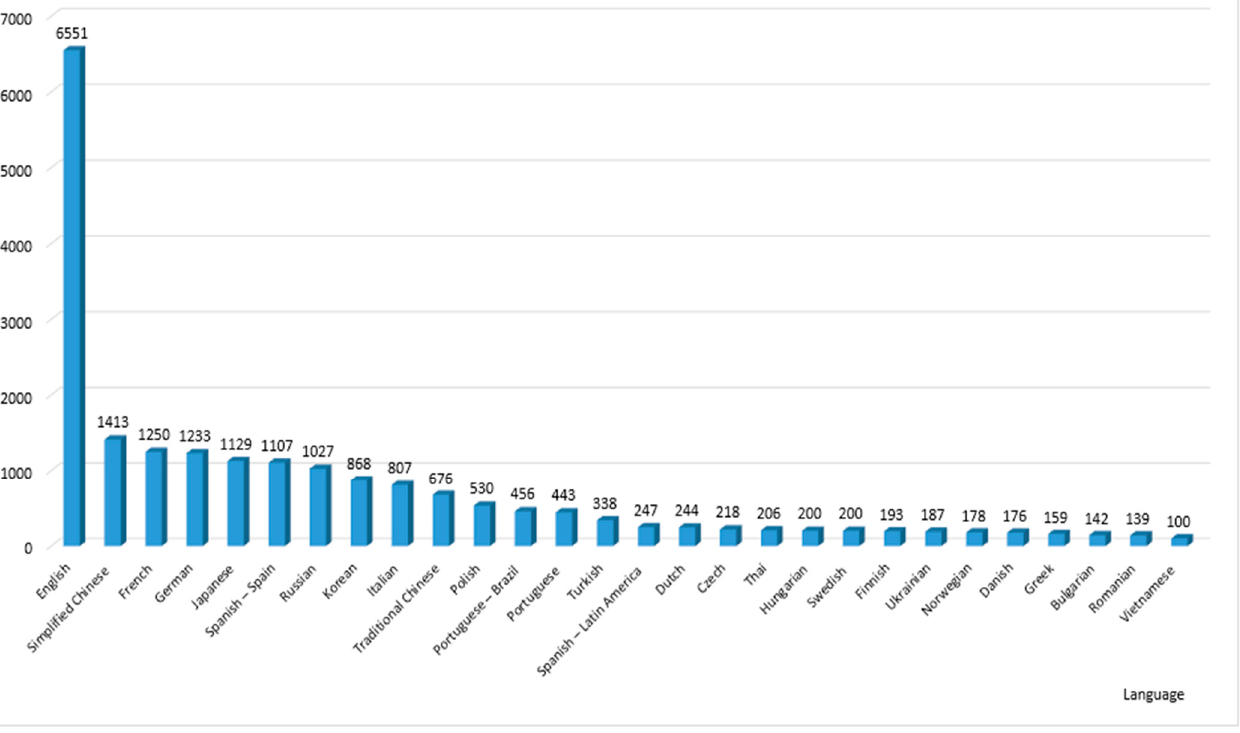
Figure 4. The number of VR applications in each language (languages with at least 100 apps) on Steam [author’s own study based on data from [35] [state on 6 July 2022].